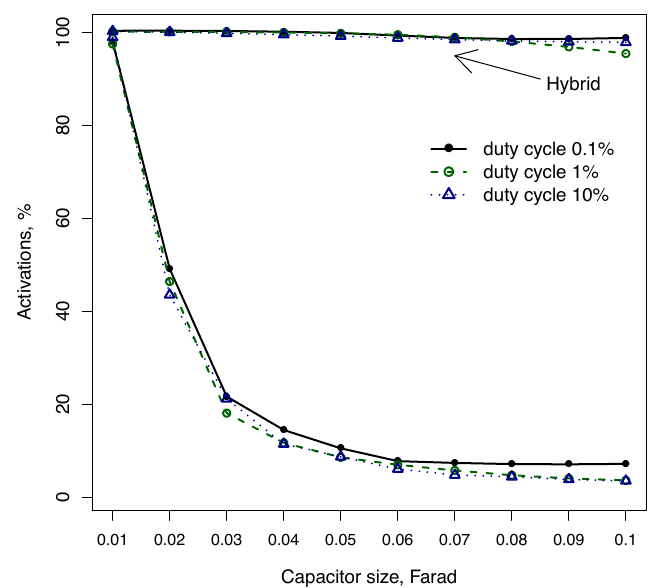
Figure 6. The number of sensor activations near charging stations in the fixed capacitor configuration drops rapidly with capacitor size as the node is less likely to boot on a larger capacitor.